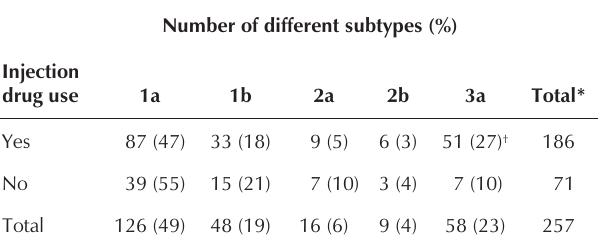
Hepatitis C virus subtypes distribution in injection drug